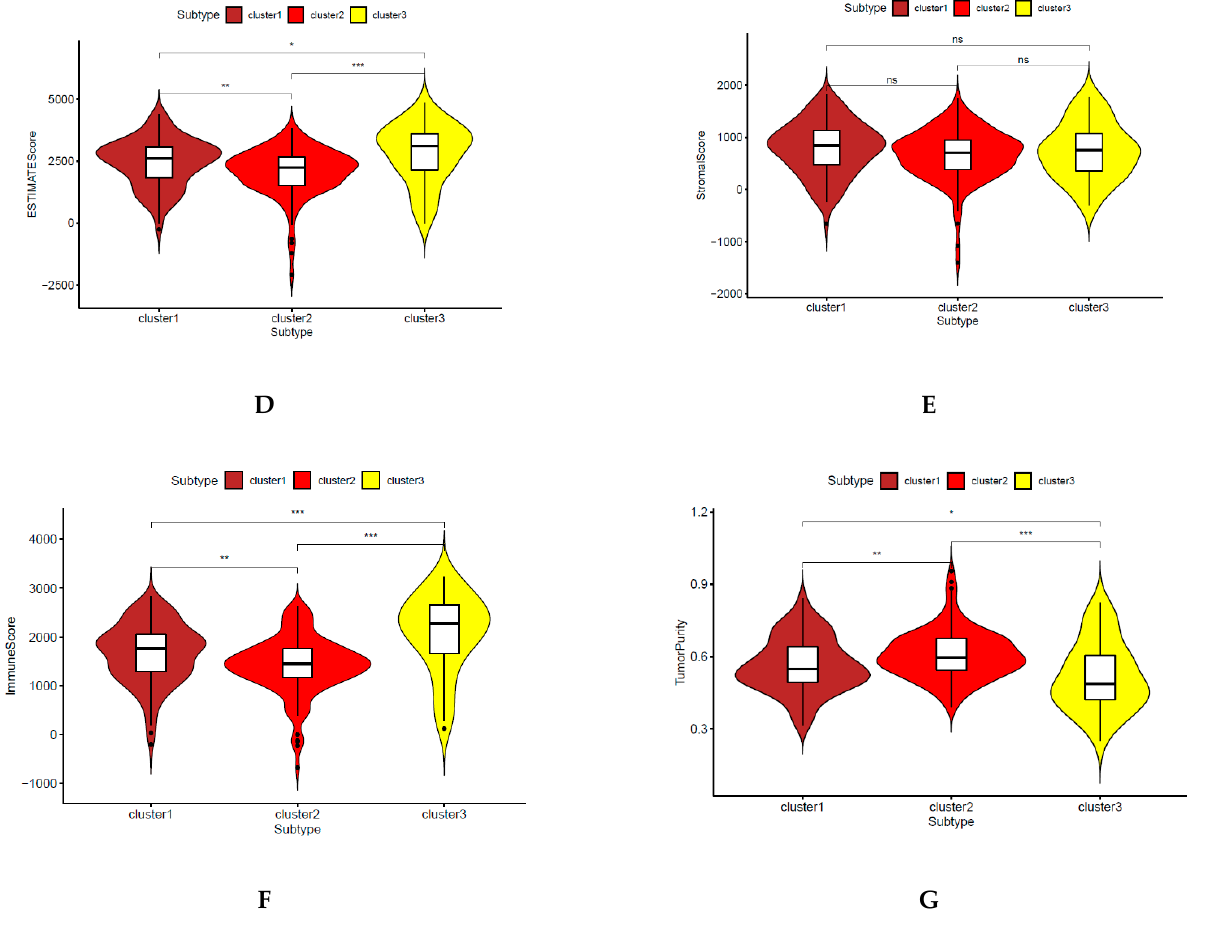
Figure 4. Immune status in different subgroups are different. ( A ) Immune infiltration level in different subgroups. ( B ). Immune infiltration cells in different subgroups. ( C ) Immune checkpoints in different subgroups. ( D – G ) Tumor microenvironment (TME). Three asterisks, two asterisks, and one asterisk represent a p -value less than 0.001, 0.01, and 0.05, respectively. NS represents no significance.